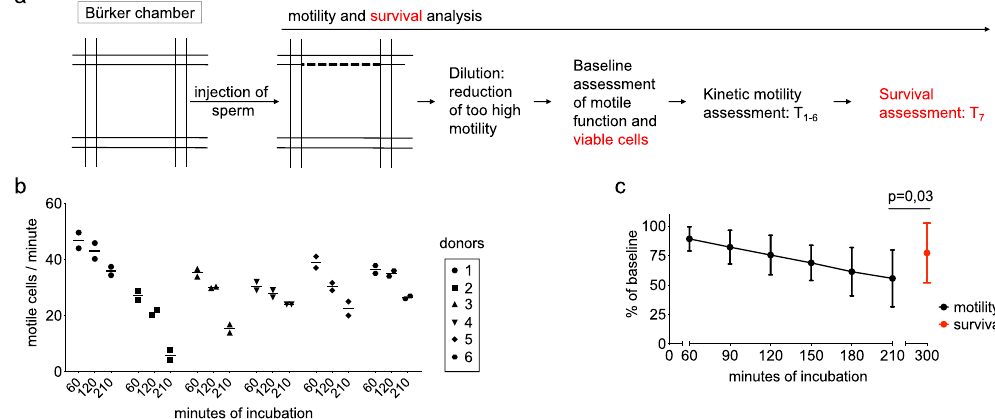
Figure 1. Analysis of motility and survival capacity of spermatozoa ex-vivo . (a) Assessment of progressively- motile spermatozoa. Dashed, bold line in Bürker chamber indicates the crossing mark for motile cells. (b) Defining precision of single-measurement analysis of motile cells. Two dots at each time point show duplicate analysis of one sample. Six donors at three points measured in independent experiments. (c) Kinetic assessment of motile function in comparison to survival. Cells analyzed at six time points for motility and thereafter, at one time point for survival. Dots represents mean of six different donors. P-value indicates significance